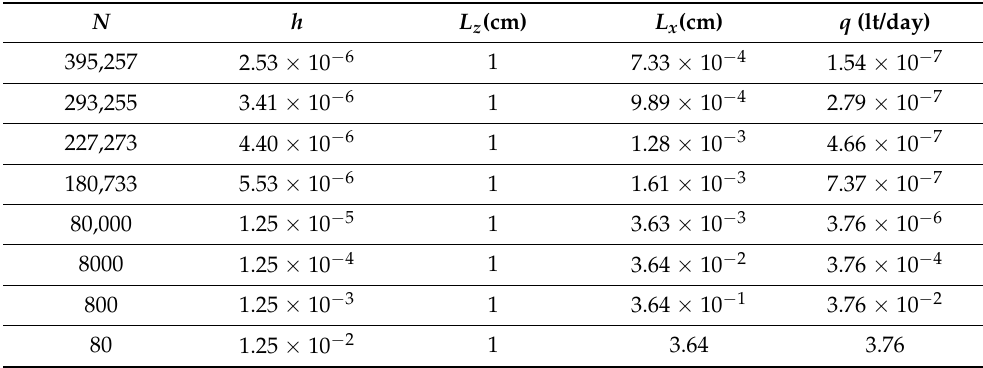
Table 1. Calculated volumetric flow rate per unit length, for various cases of cell heights and number of cells incorporated in a device. N h L z